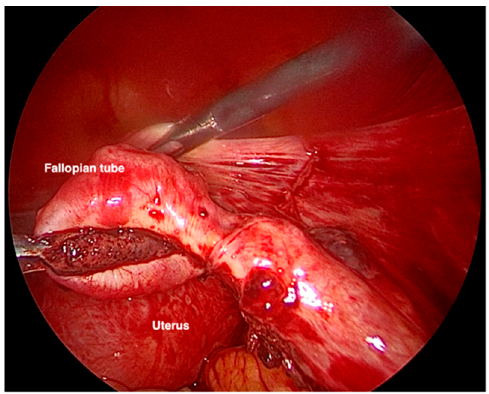
Figure 2. VLS image of the salpinx enlarged and bleeding due to ectopic pregnancy.